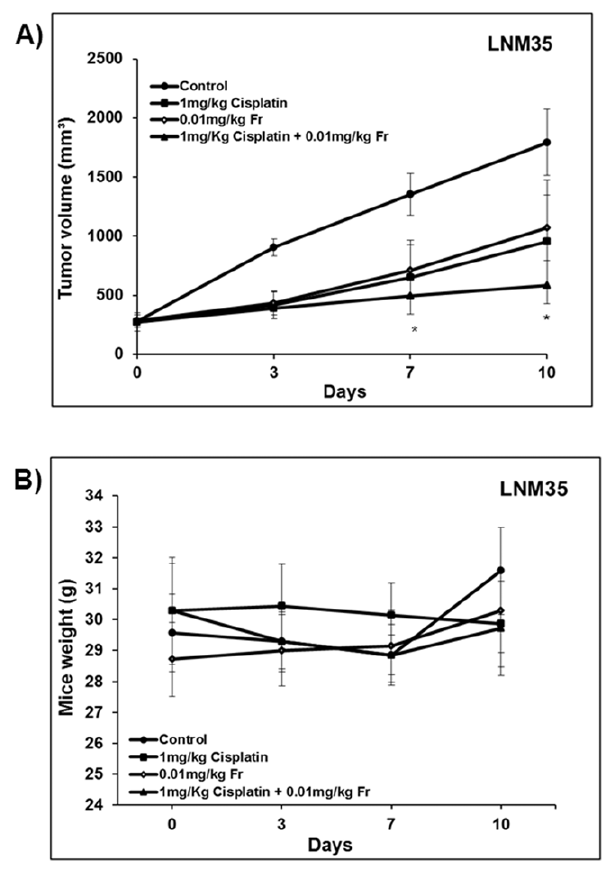
Figure 9. Antitumor activity of Frondoside A alone or in combination with the anticancer drug, cisplatin, against human lung tumor xenografts in athymic nude mice. A ) Frondoside A enhances cisplatin efficacy against NSCLC LNM35 cells growing as xenografts. B ) Impact of Frondoside A and cisplatin alone or in combination on body weight. * Significantly different at P ,